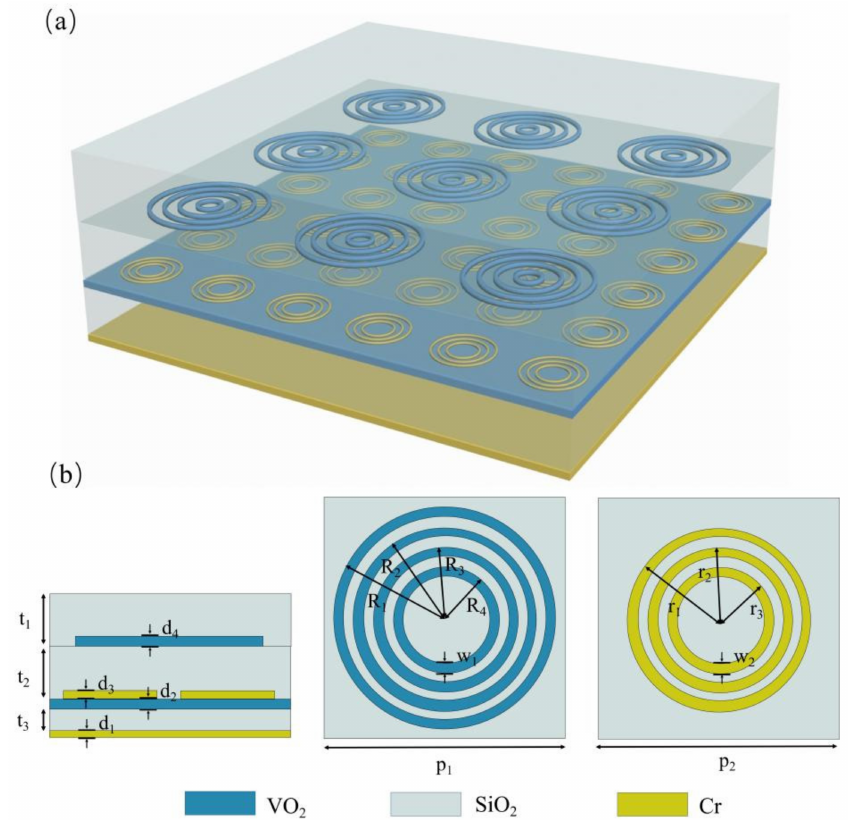
Figure 6. ( a ) Schematic of the ultra-broadband switchable absorber. ( b ) The unit cell of the meta- surface composed of multiple layers. The dimensions are t 1 = 13 µ m, t 2 = 25 µ m, t 3 = 39 µ m, d 1 = d 3 = 0.3 µ m, d 2 = 1.1 µ m, d 4 = 0.5 µ m, p 1 = 90 µ m, p 2 = 45 µ m, R 1 = 42 µ m, R 2 = 34 µ m, R 3 = 25 µ m, R 4 = 19 µ m, w 1 = 2 µ m, r 1 = 15 µ m, r 2 = 11 µ m, r 3 = 8 µ m, and w 2 = 1 µ